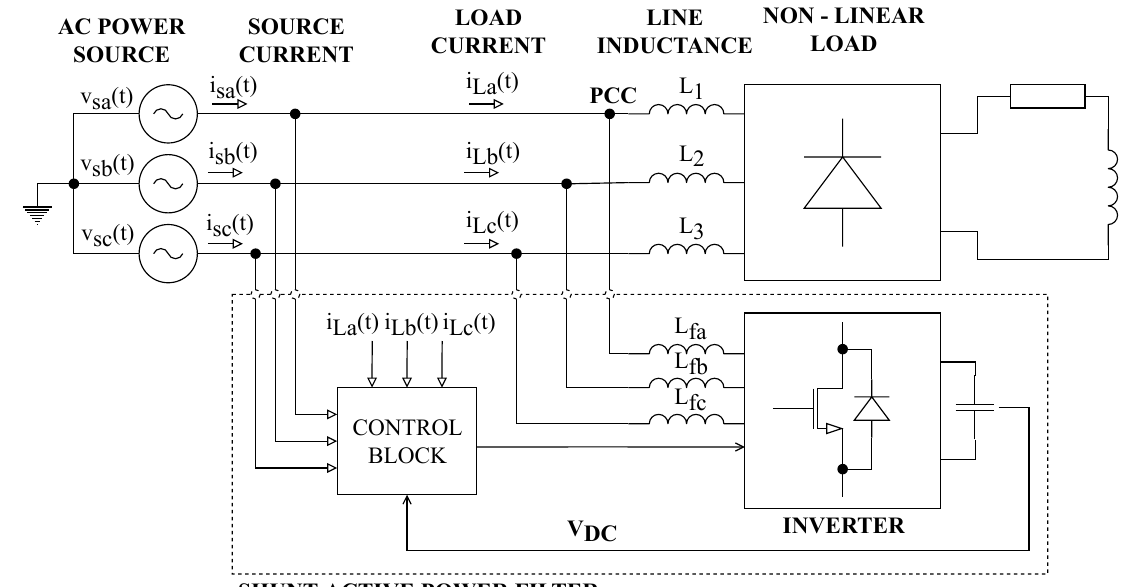
Figure 4. Block diagram of the system for compensation of higher harmonic components using Shunt Active Power Filter